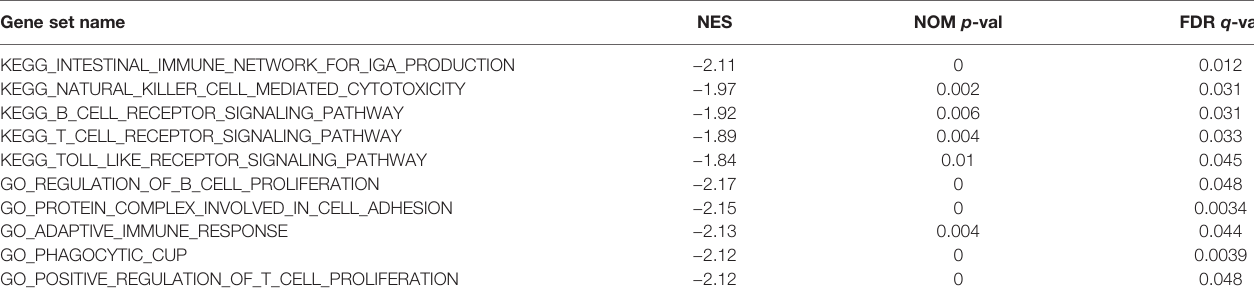
TABLE 2 | Gene sets enriched in